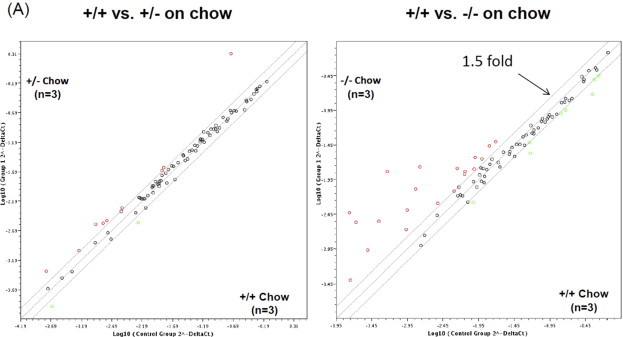
(A) Scatter plot of the expression profile of 84 genes encoding components of the NFκB pathway comparing Fto+/+ and Fto-deficient mice (Fto+/− left panel or Fto−/− right panel) fed on standard chow. Each dot represents a gene and red dots are those that are up-regulated in Fto-deficient mice while green dots represent genes that are down-regulated with Fto-deficiency. (B) Gene expression profile of components of the NFκB pathway comparing Fto+/+ on standard chow versus Fto+/+ mice exposed to 5 weeks of high-fat diet. (Left panel) Data presented as scatter plot obtained by plotting the log of the average normalised signal intensity of genes in the HFD state against the chow fed state. (Right panel) bar graph presented genes regulated by at least 1.5-fold following a high-fat feeding.